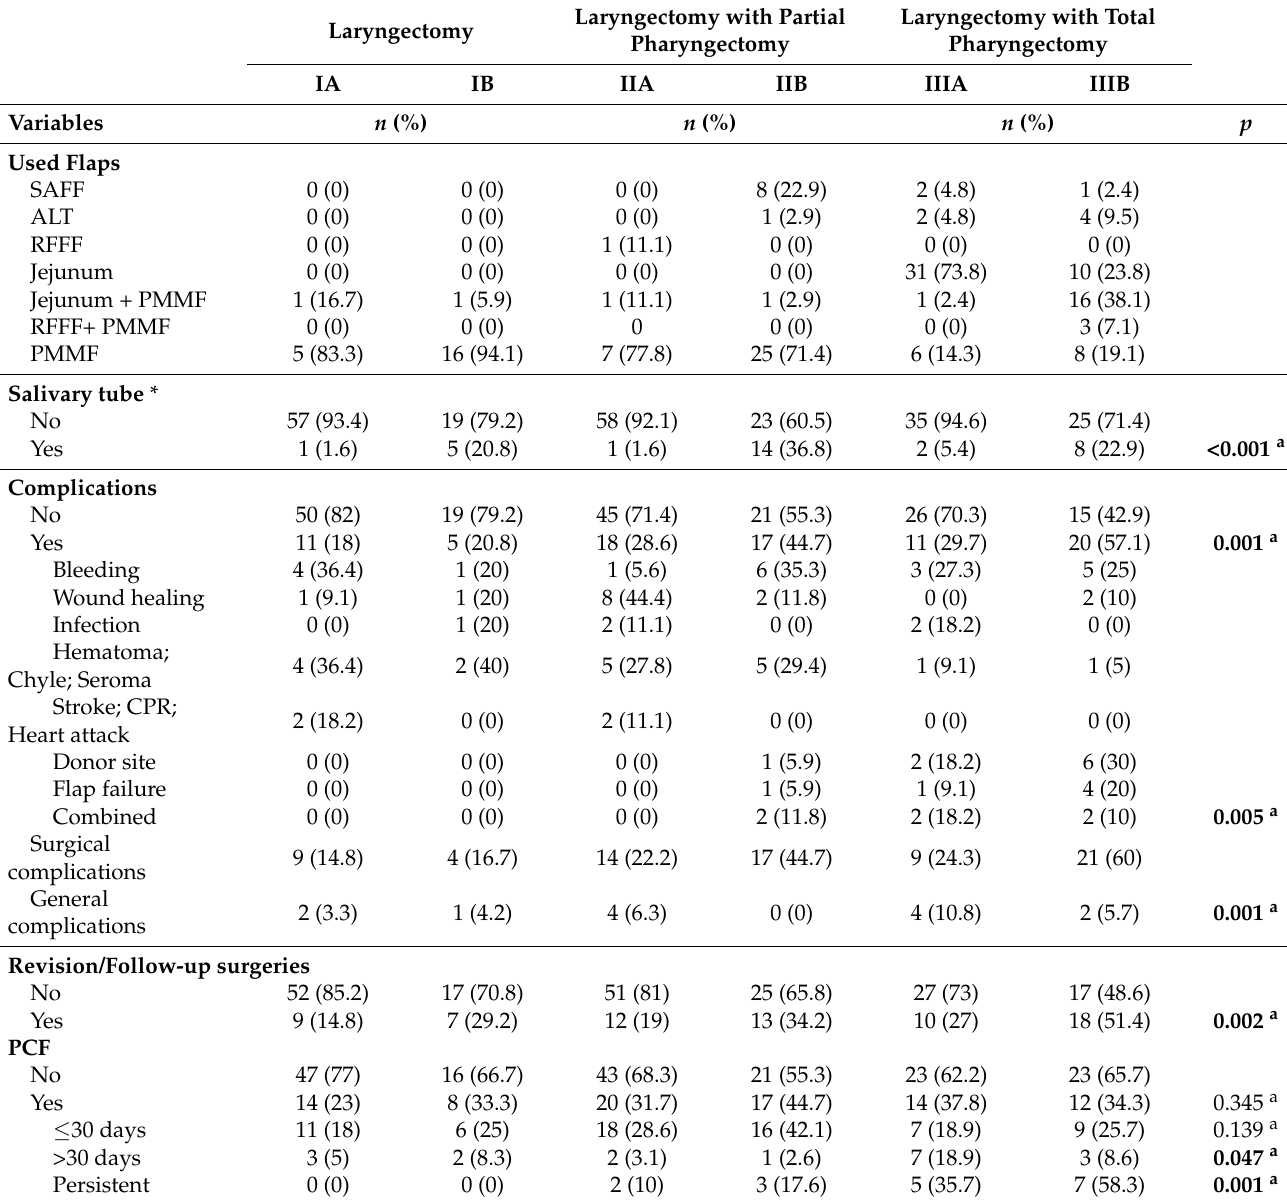
Table 2. Surgical ablation, reconstruction and complications according to the Vienna Larygopharyngectomy Classification system. Laryngectomy with Partial Laryngectomy with Total Laryngectomy Pharyngectomy Pharyngectomy IA